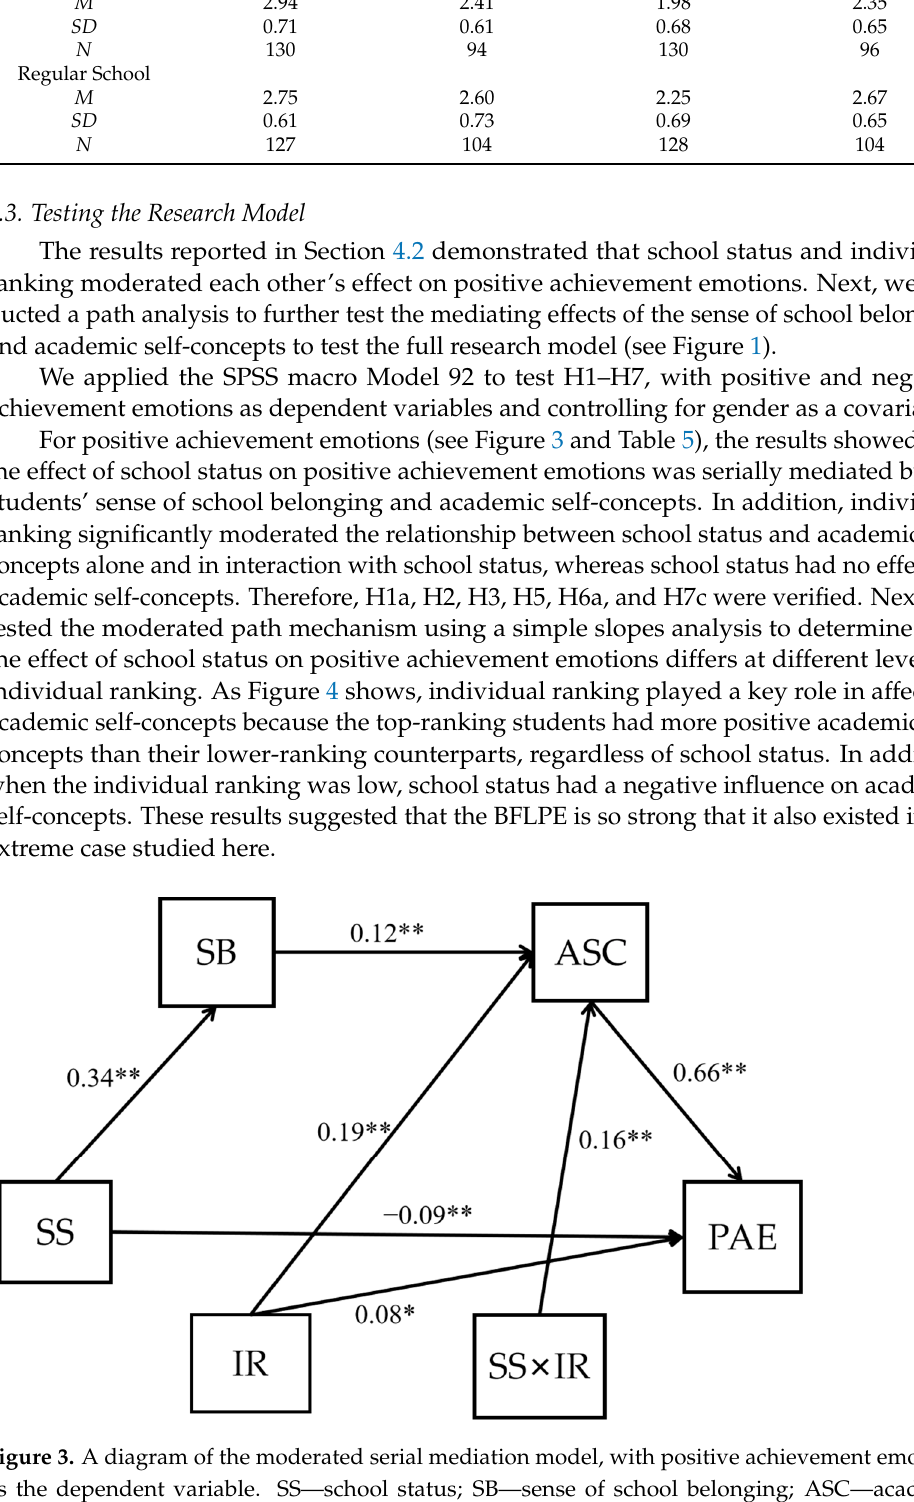
Table 4. ANOVA results for positive and negative achievement emotions. Positive Achievement Emotions Negative Achievement Emotions Top-Ranking Bottom-Ranking Top-Ranking Bottom-Ranking